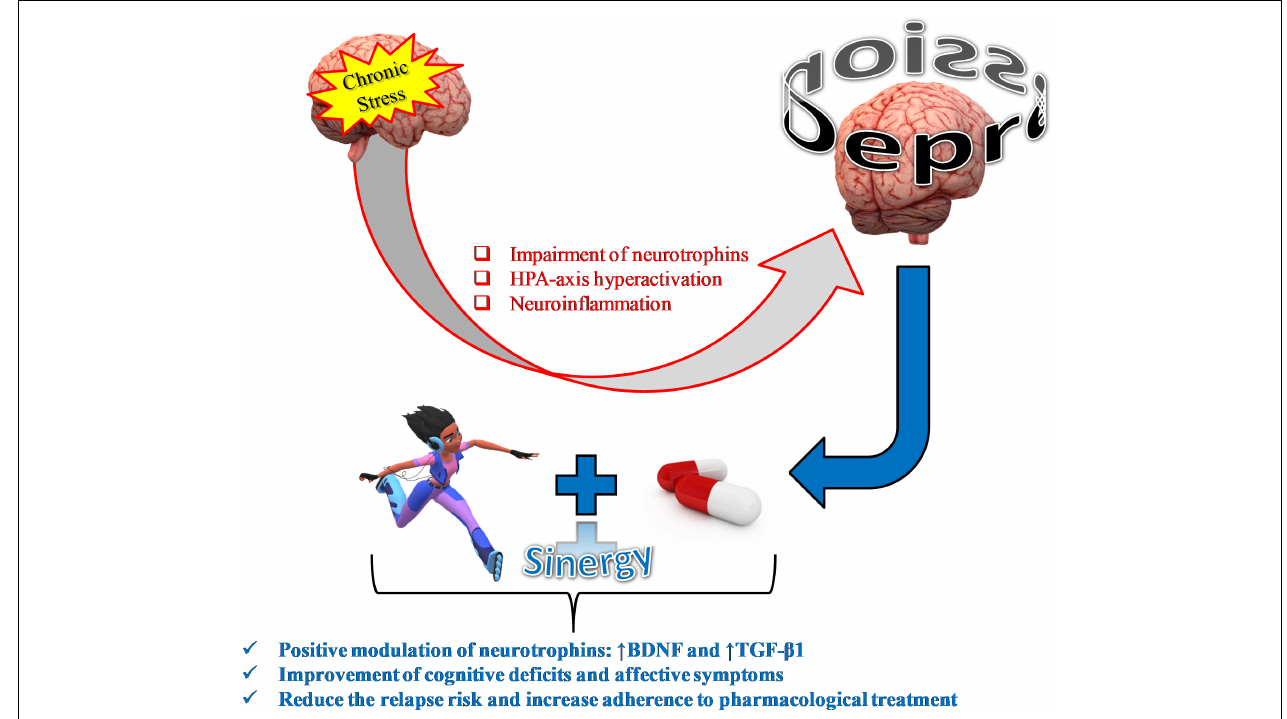
FIGURE 1 | Physical activity as an add-on treatment strategy to antagonize stress-induced depression.